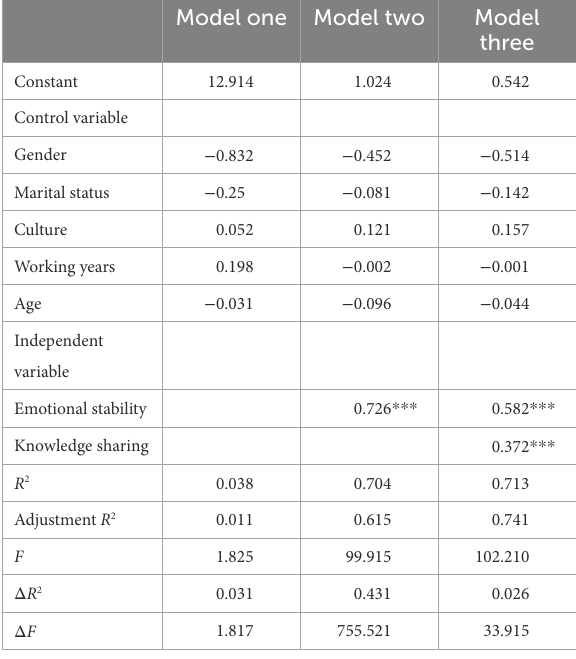
TABLE 8 Regression analysis of emotional stability and knowledge sharing on breakthrough innovation